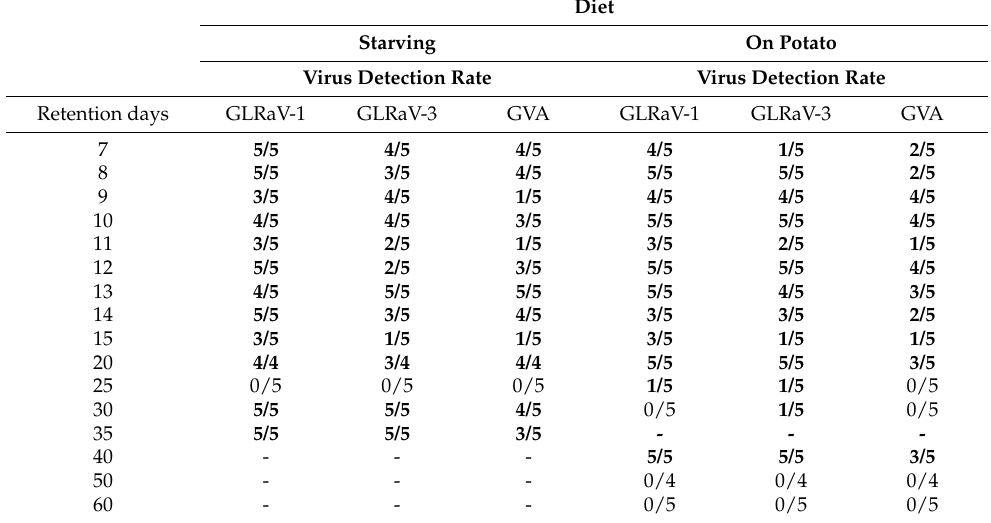
Table 10. Detection rates of GLRaV-1 and -3, and GVA in Heliococcus bohemicus L2 batches, after 3 days acquisition on accession Y258 (infected by GLRaV-1 and -3, and GVA), and various times starving or confined on potato (number of virus positive batches/number of surviving batches). Positive detections are highlighted in